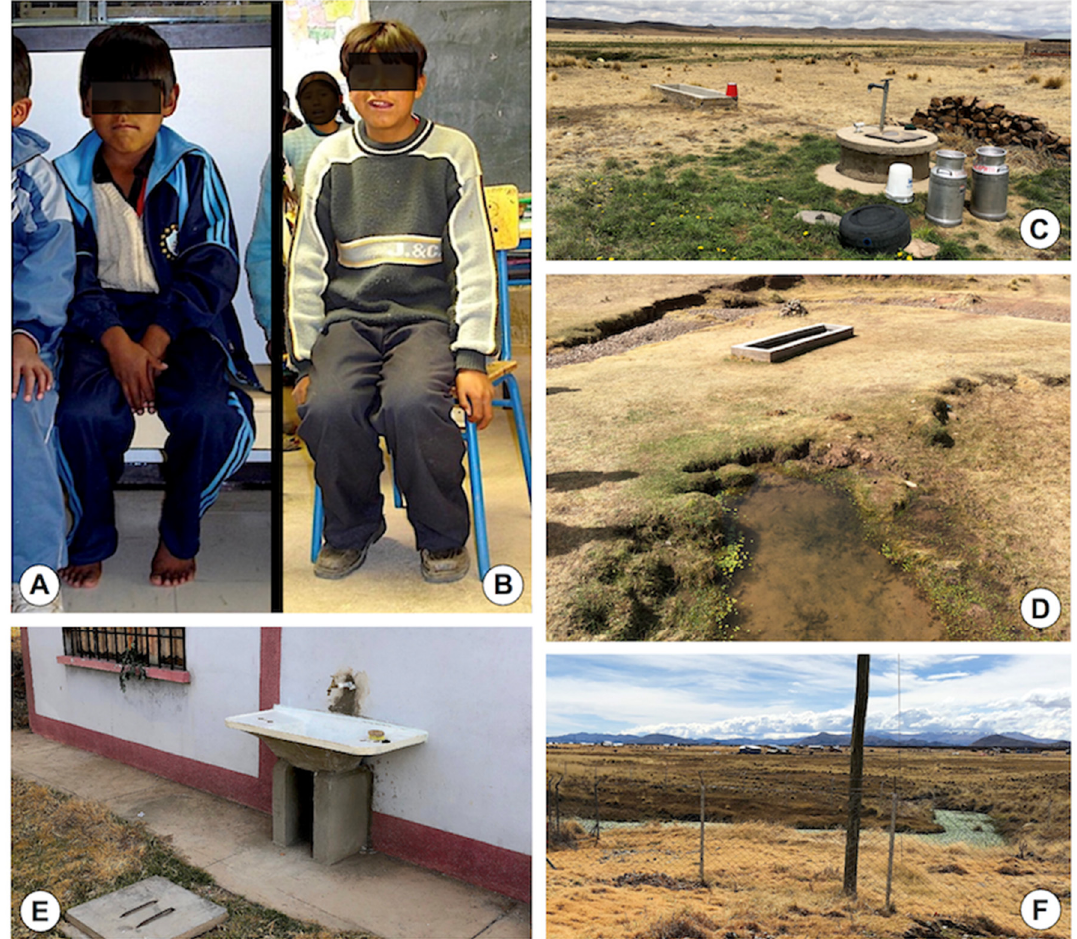
Figure 11. Control measures: ( A , B ) A 13-year old boy weighing only 26 kg and shedding 384 F. hepatica eggs per gram of faeces on 23 June 2008 in Hospital del Niño of La Paz ( A ) pronouncedly improved in development to 41 kg in 12 November 2008 in Huacullani when coprologically negative after treatments in the yearly preventive chemotherapy programme ( B ); ( C ) Well and recently constructed drinking-trough for livestock, in Challapata; ( D ) Artificial drinking-trough for livestock constructed besides freshwater collection inhabited by lymnaeid vectors and surrounded by animal stools, in Santa Rosa; ( E ) External faucet and basin in front of a health centre, in Huacullani; ( F ) Fences installed around transmission focus inhabited by lymnaeid vectors besides hyperendemic village, in Huacullani. ( A , B ) Photographs R. Angles; ( C – F ) Photographs S. Mas-Coma; E and F modified from Bargues et al., Parasit. Vectors 2020, 13,